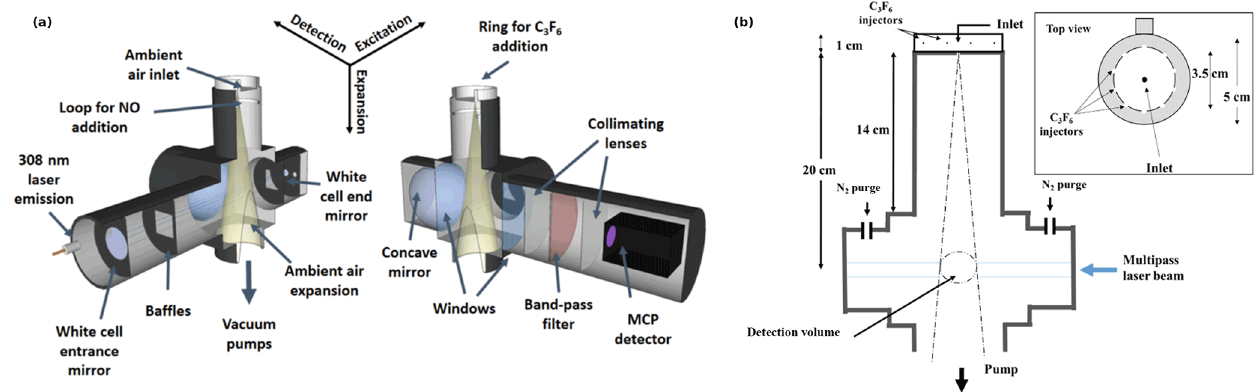
Figure 2. Schematic of the IU-FAGE sampling and excitation axis (a) and cross section with dimensions for the medium inlet configura- tion (b)